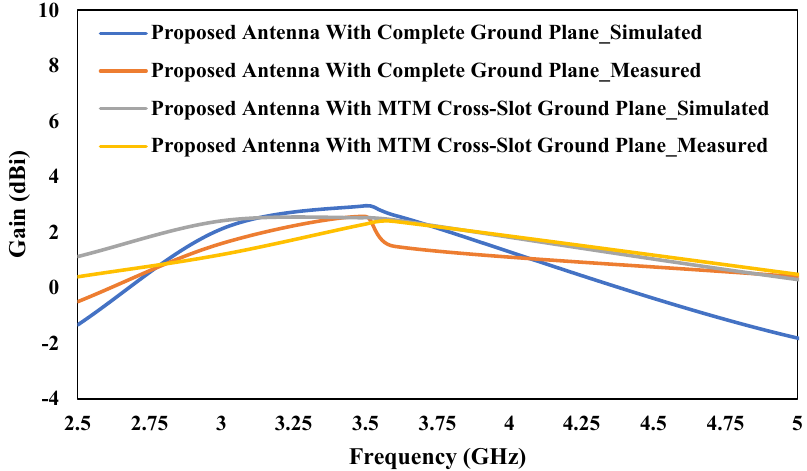
Figure 19. Simulated and Measured gain versus frequency graph for both proposed antennas.